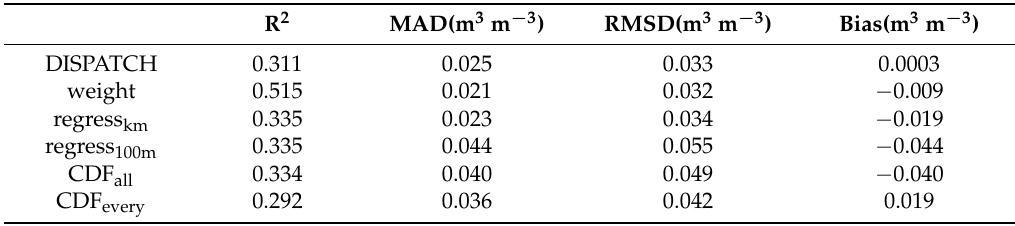
Table 2. Statistical evaluation of the 1 km DISPATCH product and the applied methods against the in situ measurements. R 2 MAD(m 3 m − 3